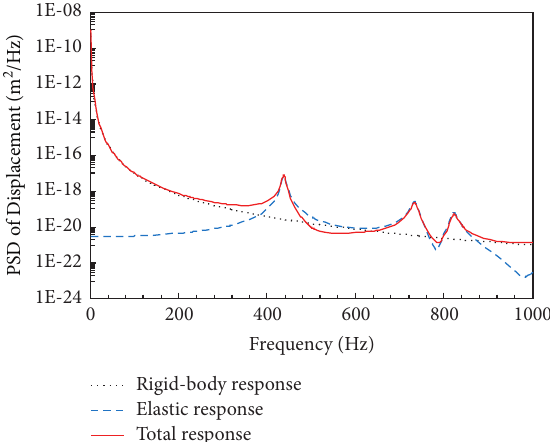
Figure 11: The comparison of PSD responses.